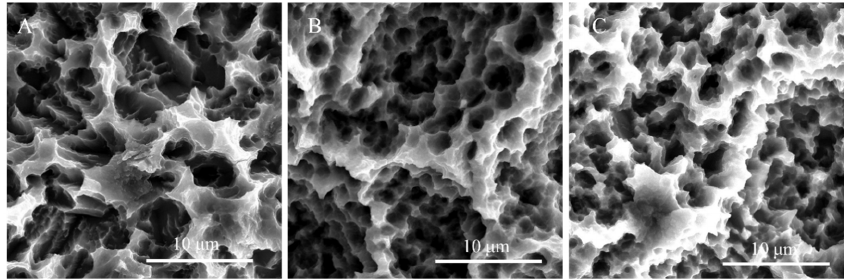
Figure 1. Morphology of Ti samples before and after treatment: ( A ) SLA, ( B ) Oxidation, ( C ) Storage.